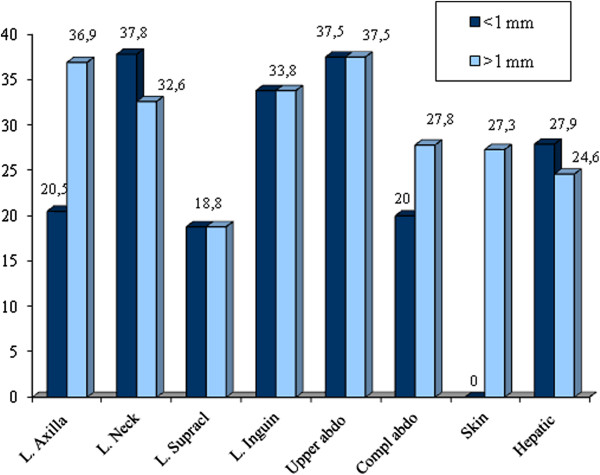
Inappropriated test according to tumor localization for patients of Group A and Group B.